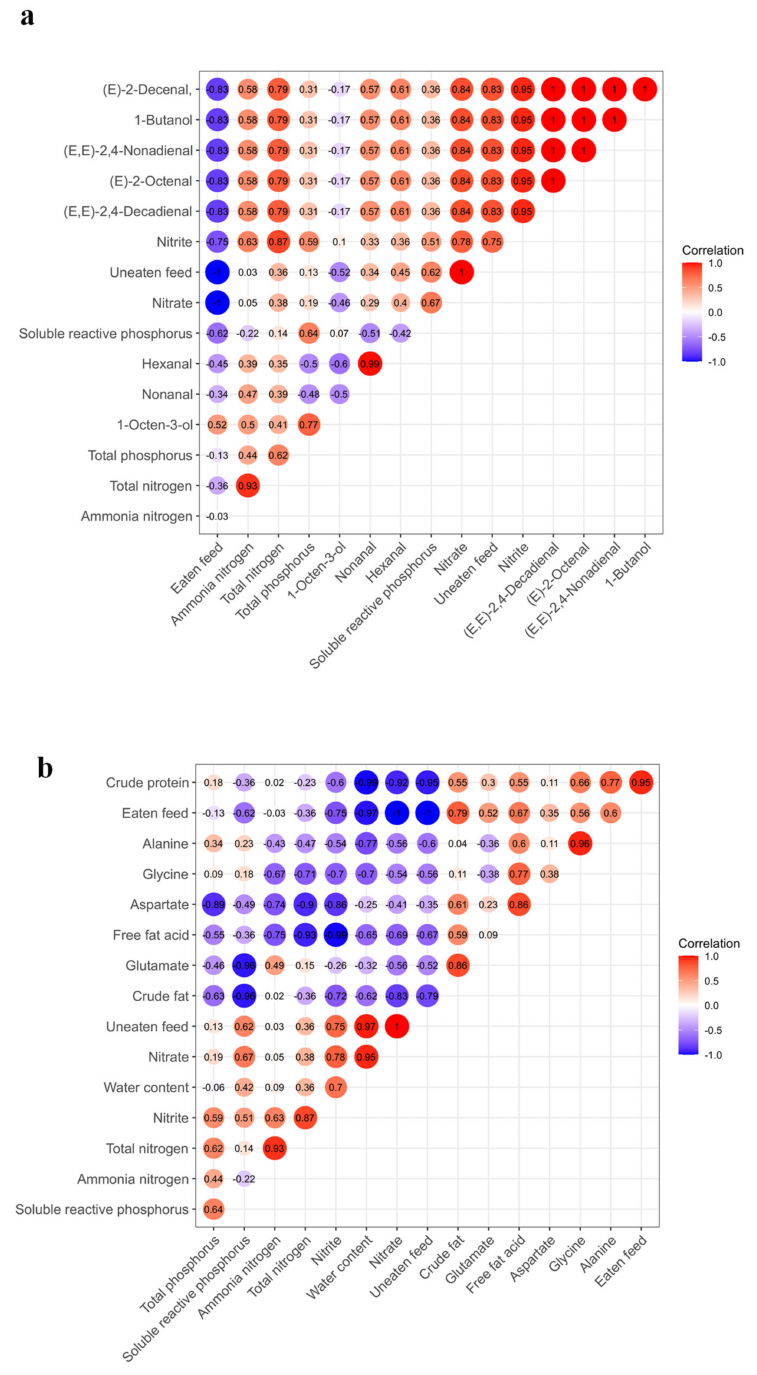
Figure 4. The correlation between flesh quality parameters (main flavor compounds ( a ) and nu- tritional values ( b )) and affecting factors (water quality parameters and feed). Red represents a positive correlation, and blue represents a negative correlation. The numbers in the circle represent the correlation